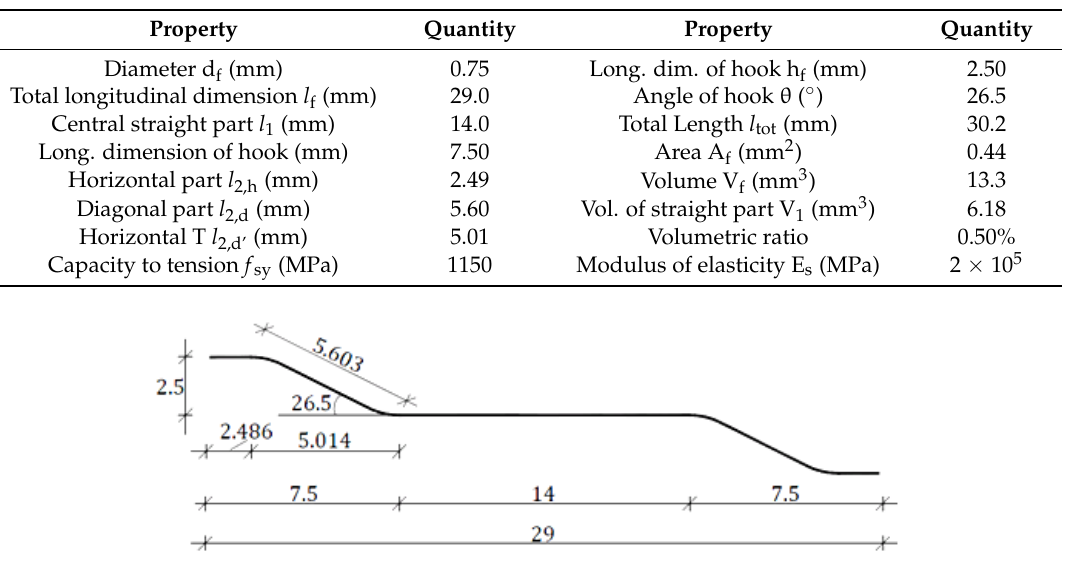
Table A1. Characteristics of the case study fibers.